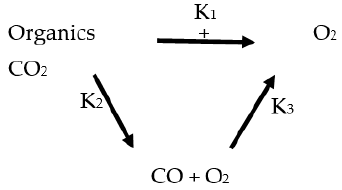
Figure 7. A two-stage oxidation mechanism according to Portela et al. [61].